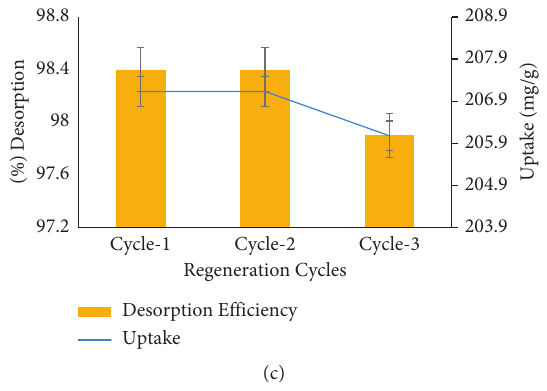
Figure 7: Desorption efficiency (a) elutants, (b) S/L ratio, and (c) regeneration